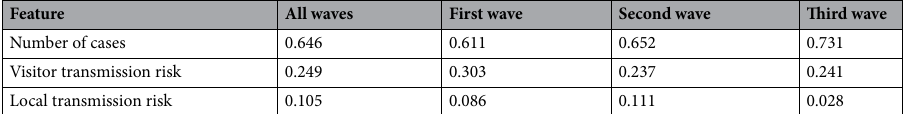
Table 5. The importance of various features to calculate the future number of cases using a random forest regression.